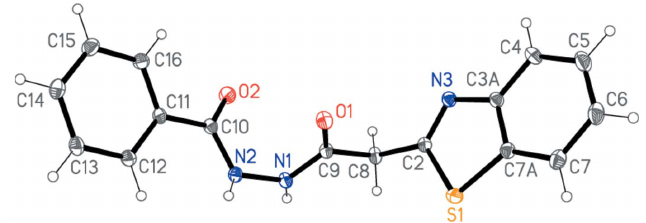
Figure 1 The molecule of compound 3 in the crystal. Ellipsoids represent 50% probability levels.